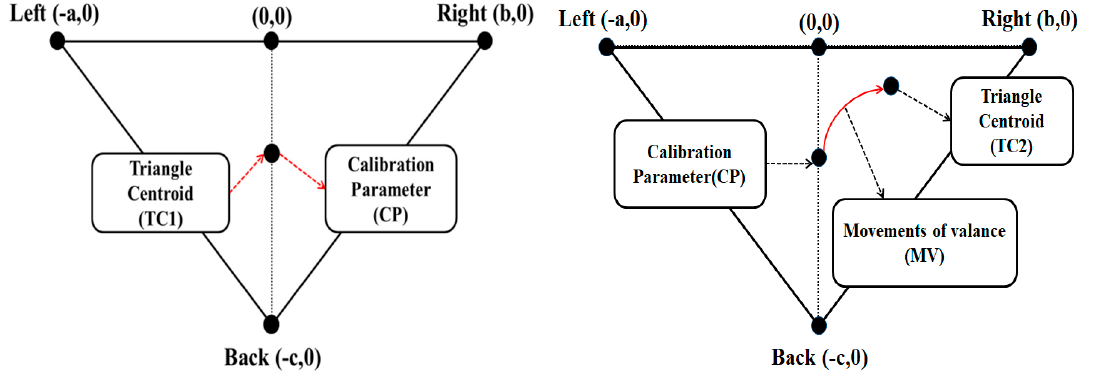
Figure 3. Triangle centroid detection technique.